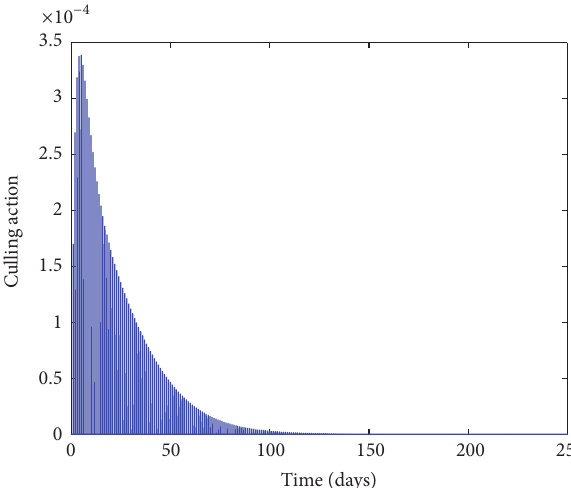
Figure 21: Evolution of the total alive population with daily culling rate of 𝜌 𝐷 = 0.1 , feedback vaccination 𝑉 = 0.2𝑏 1 + 0.002𝑆(𝑡) , and antiviral treatment 𝜉(𝑡) = 𝐾 𝜉 𝐼(𝑡) = 0.01𝐼(𝑡) .